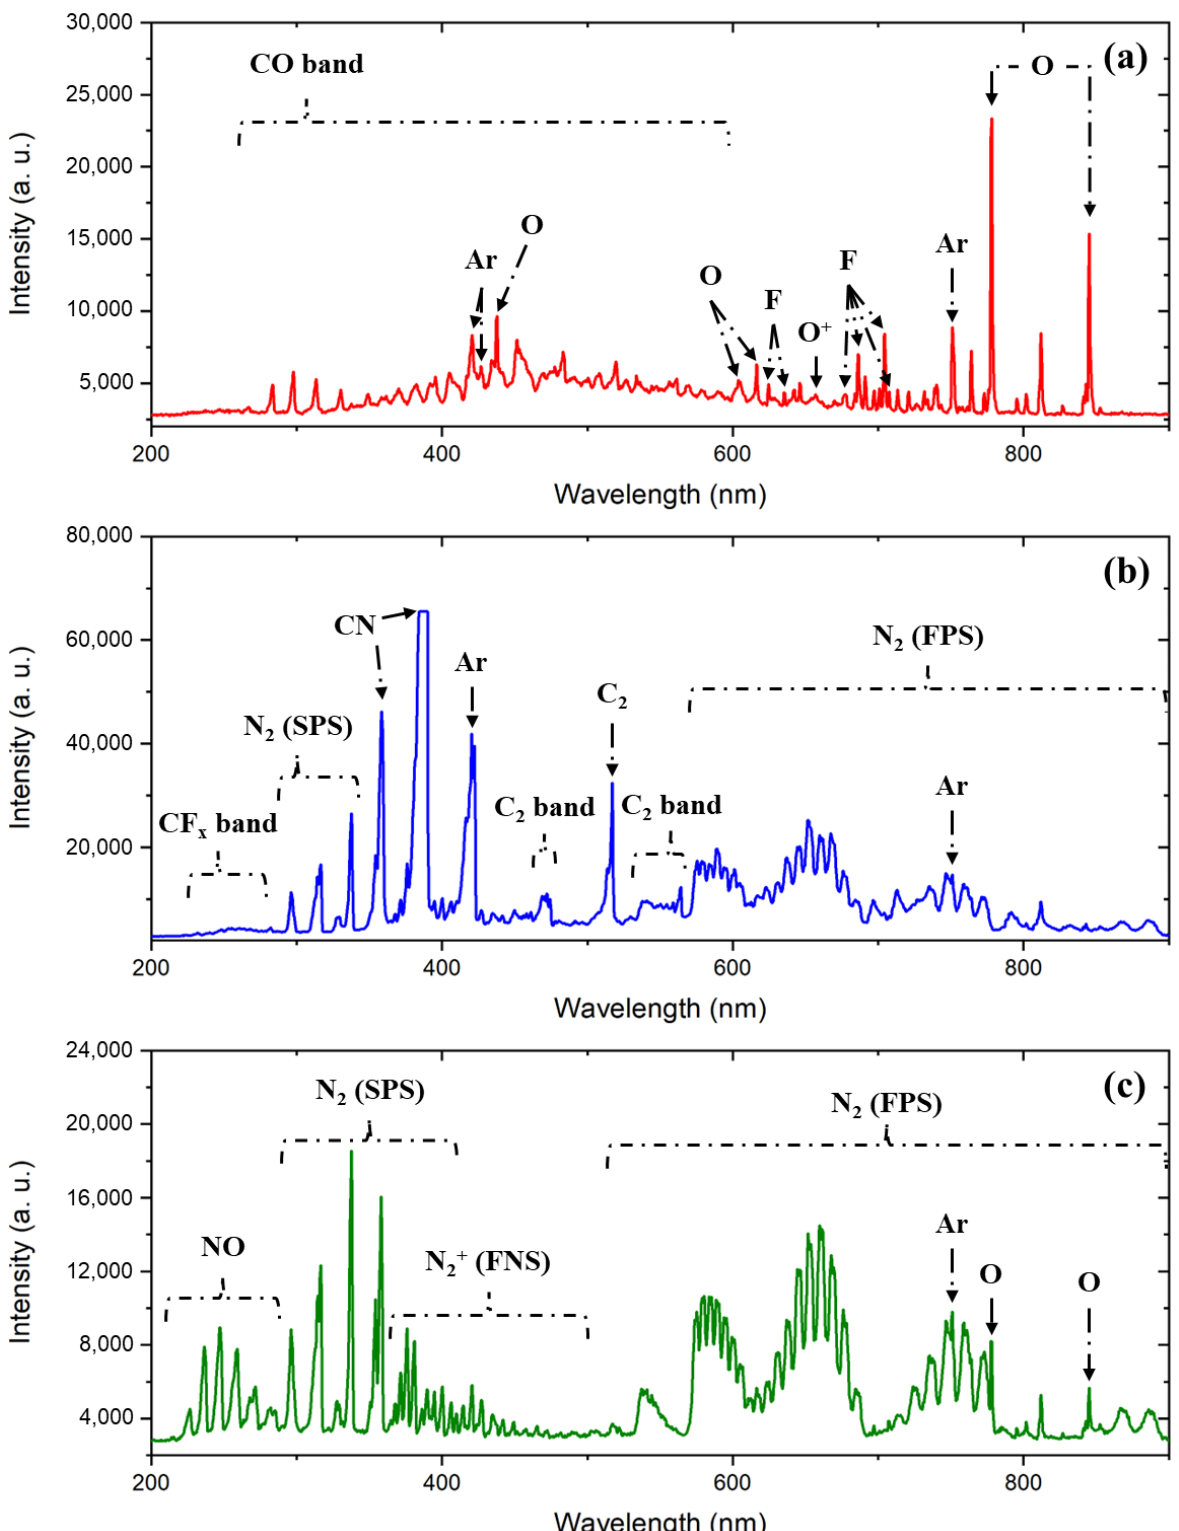
Figure 5. ( a ) CF 4 /O 2 , ( b ) CF 4 /N 2 , ( c ) O 2 /N 2 OES spectrum. Molecular species such as CO, CN, and NO, generated by the reactions of two injected gas species, are observed.